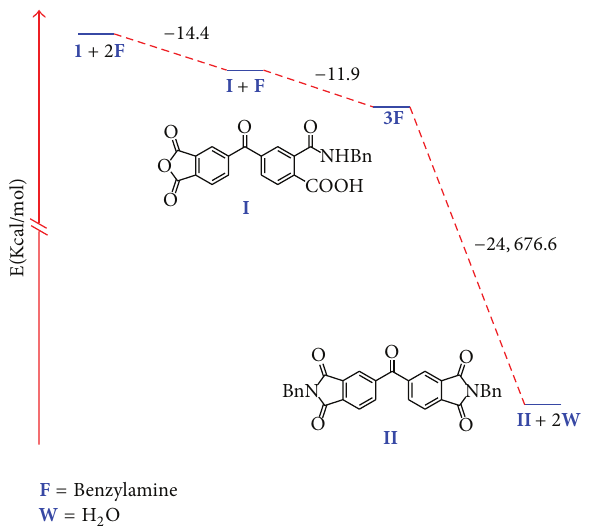
Figure 5: Energy diagram for the reaction pathway of dianhydride 1 and benzylamine.